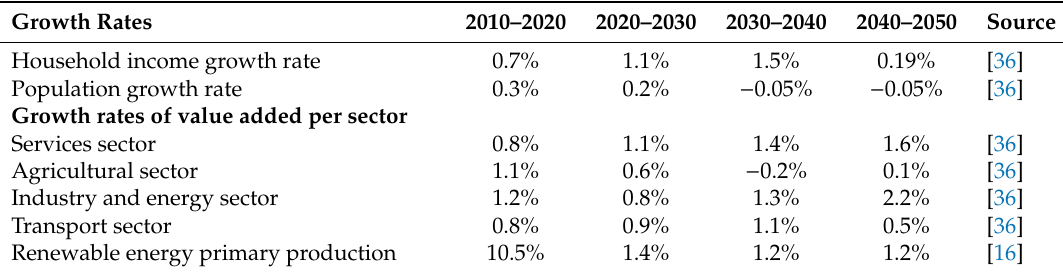
Table 2. Annual exogenous growth rates of group incomes, population [36], and renewable energy production in the Netherlands